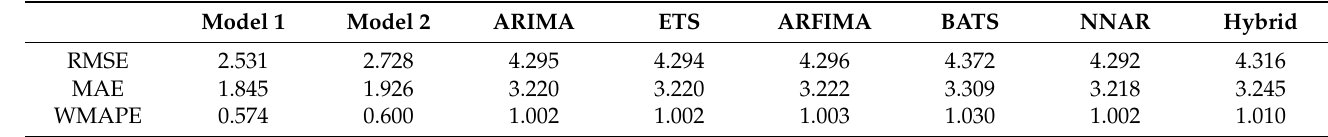
Table 8. Measures of accuracy of forecasting